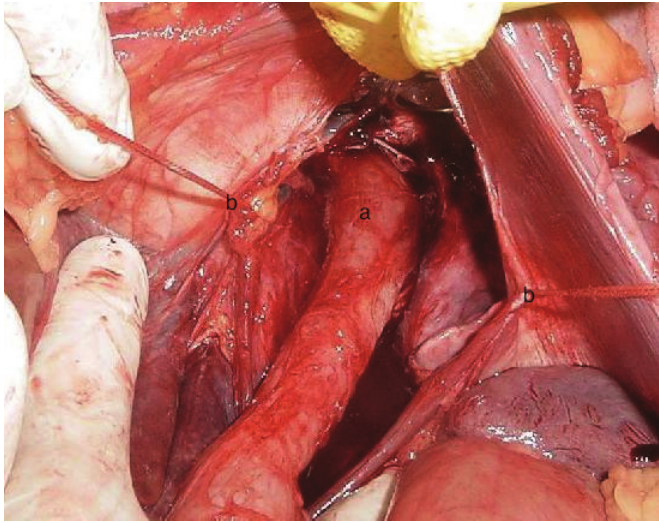
FIgURE 4 - Model of group B, showing the esophagus ( a ) dissected in the posterior mediastinum after large phrenotomy. the repair stitches ( b ) observed were made to restore the baseline morphology of the hiatus, after dissection and perform the